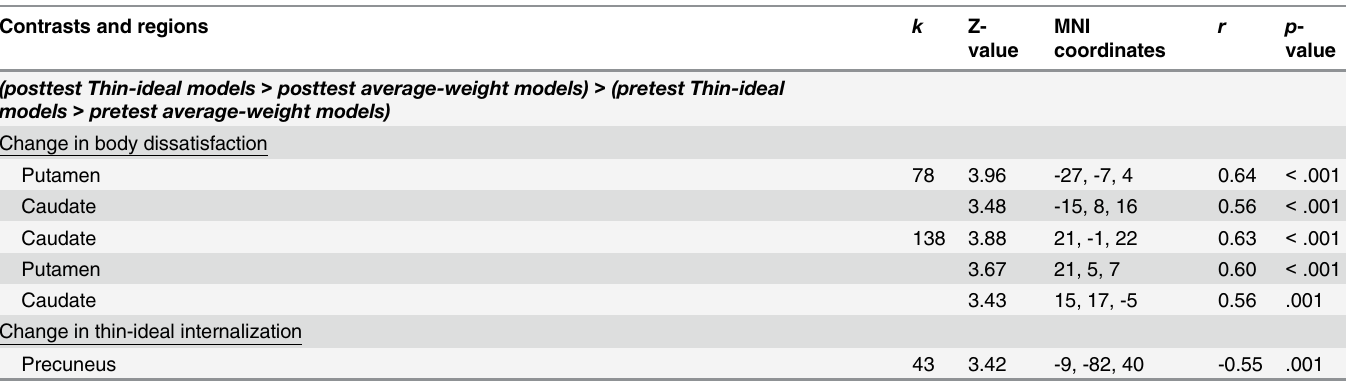
For all contrasts, activated regions, Z -values, and coordinates within the MNI coordinate system are displayed. Number of contiguous voxels ( k ) are shown for peak